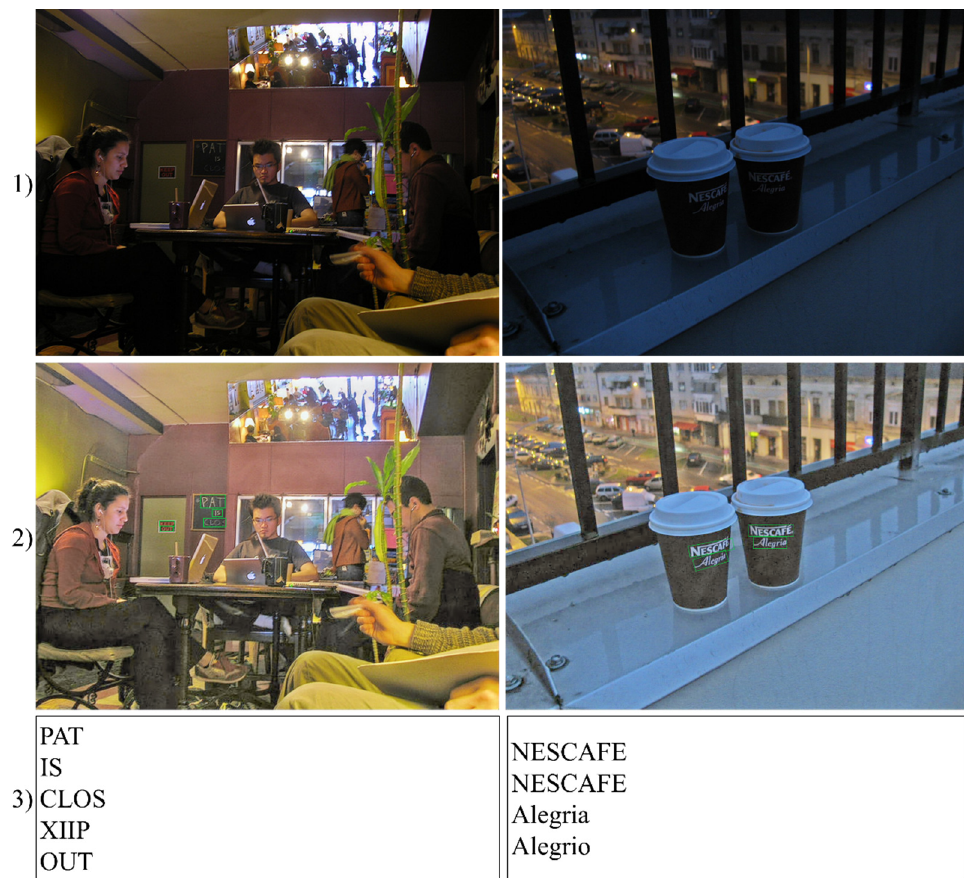
Figure 17. The results of scene text-to-speech model on the challenging ExDark datasets. ( 1 ) low-light input images; ( 2 ) text detection; ( 3 ) recognized text.